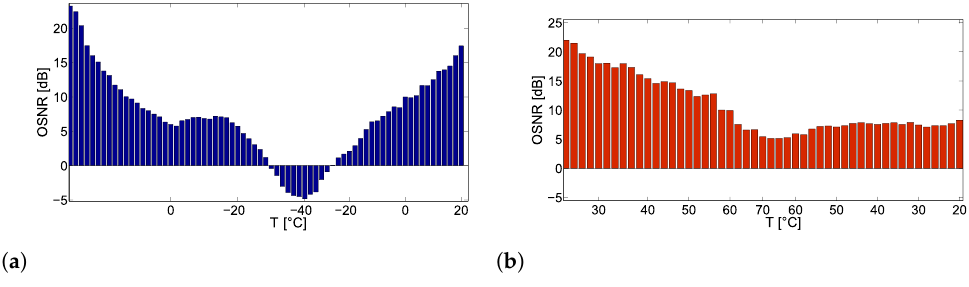
Figure 5. Influences of fiber ( a ) cooling and ( b )